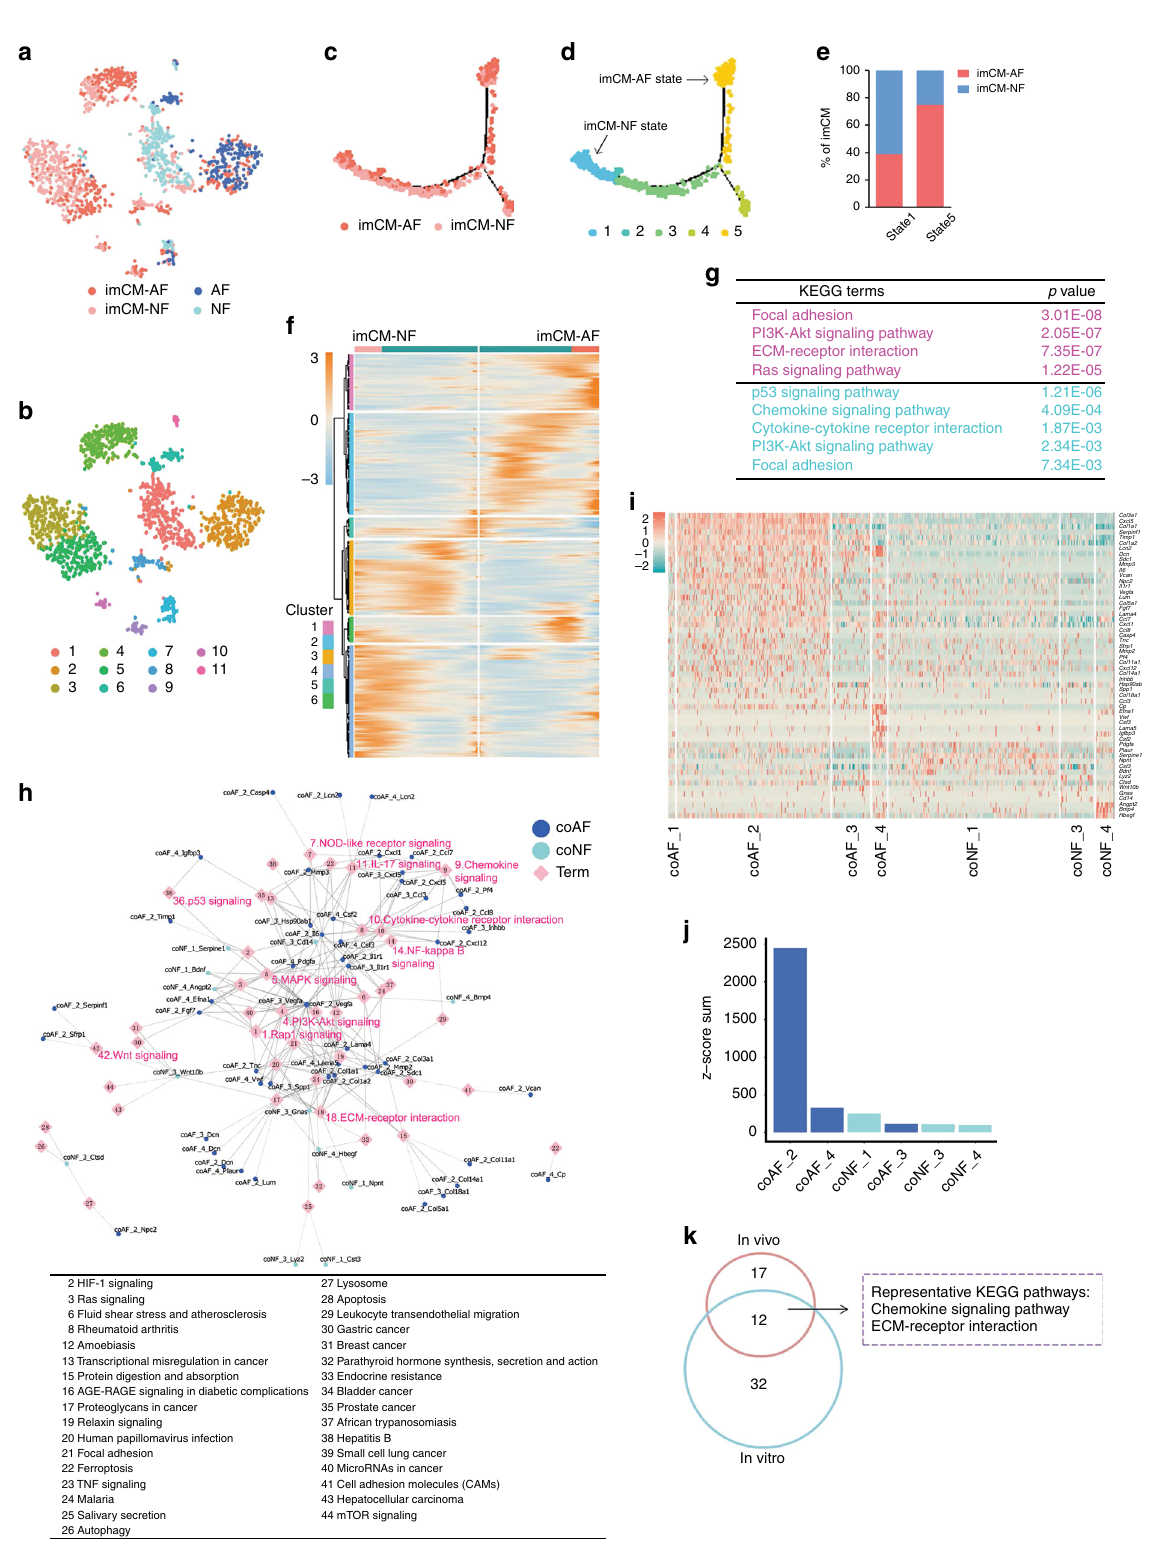
replication and nuclear division, suggesting maturation of CMs (Fig. 9g). Noteworthily, Plerixafor and BP-1-102 failed to sup- press co-culture-induced hESC-CM maturation, suggesting dif- ferential utilization of signaling pathways in AF-induced CM maturation in different species (Supplementary Fig. 9d – g).